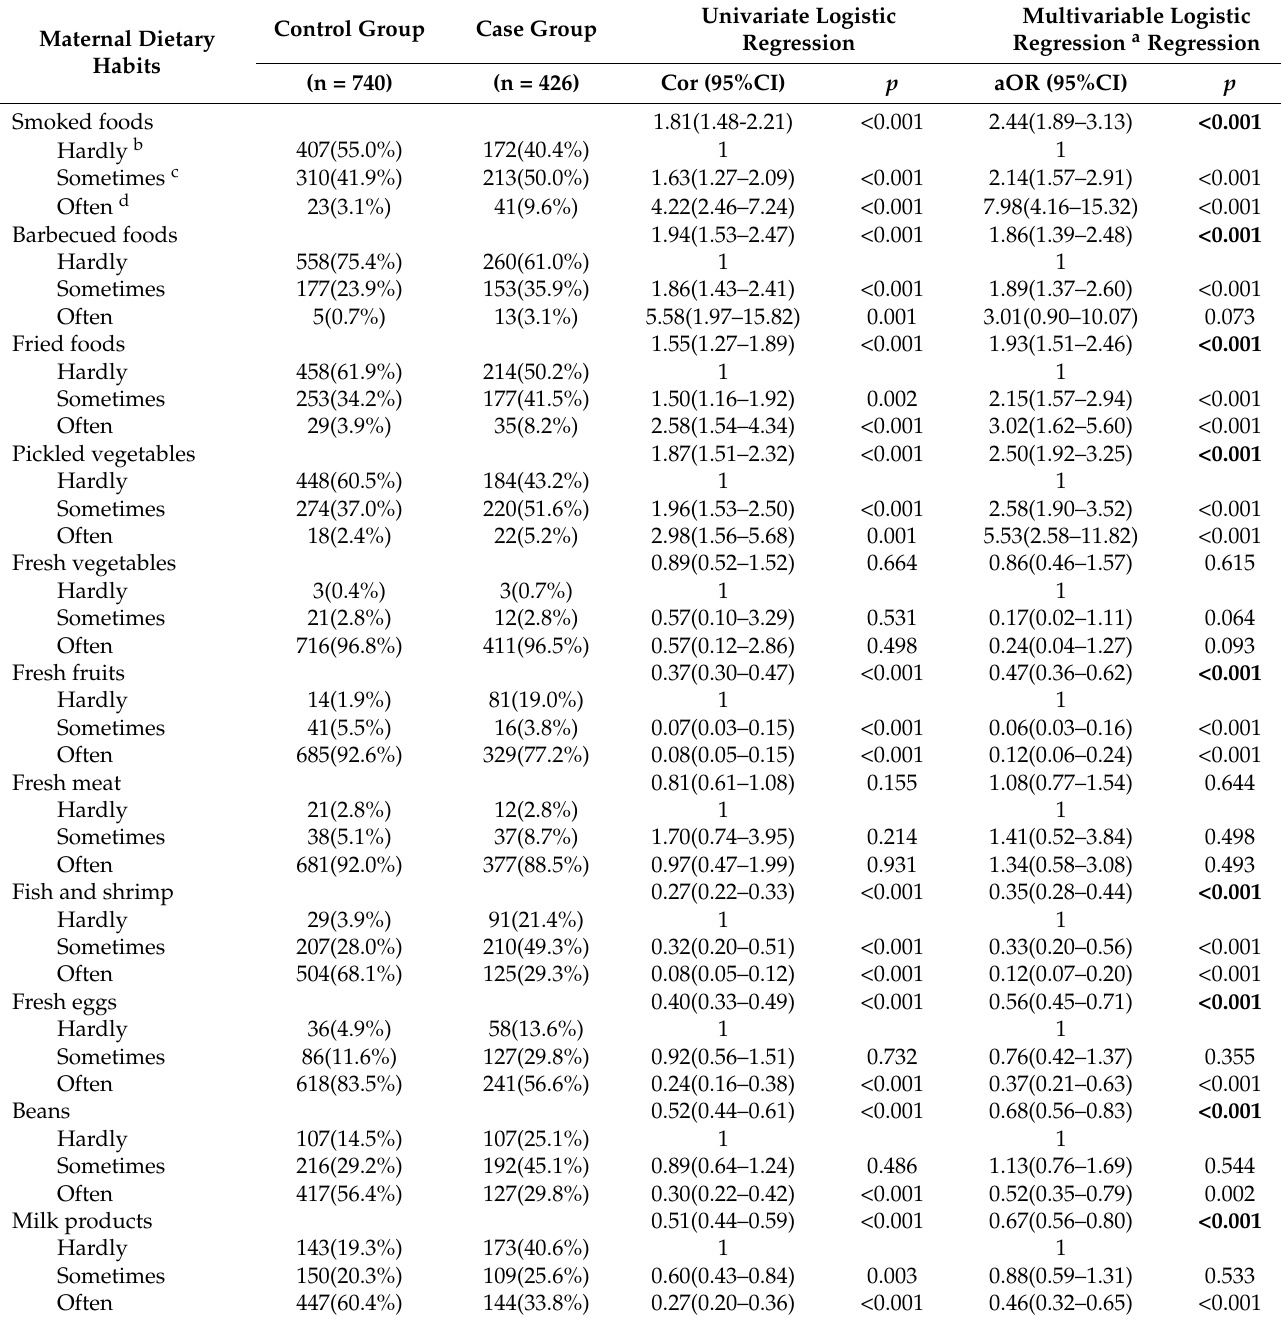
Table 2. Maternal dietary habits and the risk of VSD in